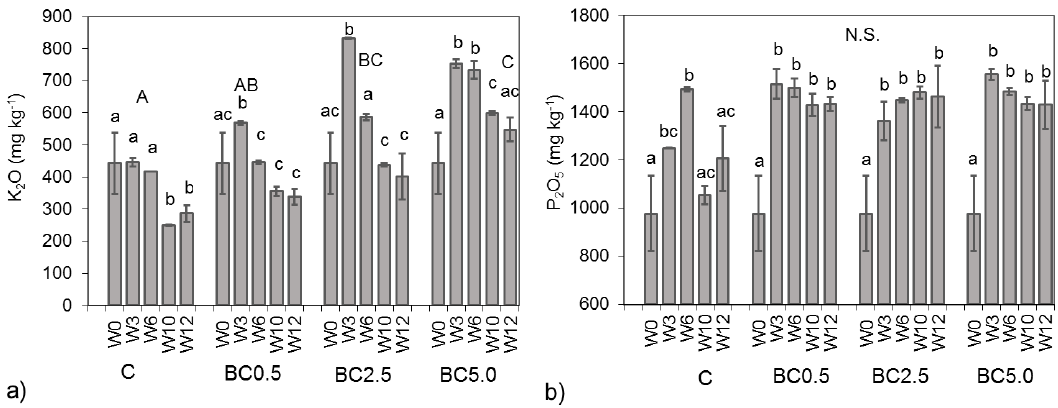
Figure 4. Temporal changes of soil ( a ) K 2 O and ( b ) P 2 O 5 concentrations during the study. Error bars represent standard deviations of three replicates per treatment. Statistically significant differences ( p < 0.05) are indicated by different letters, while N.S. signifies not significant differences between treatments.